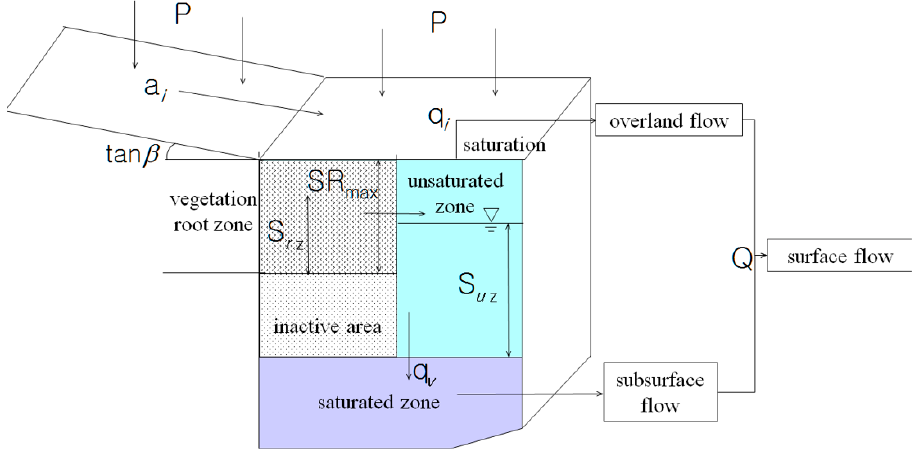
Figure 2. Basic concept of the TOPMODEL scheme (modified from [5,14,19]).